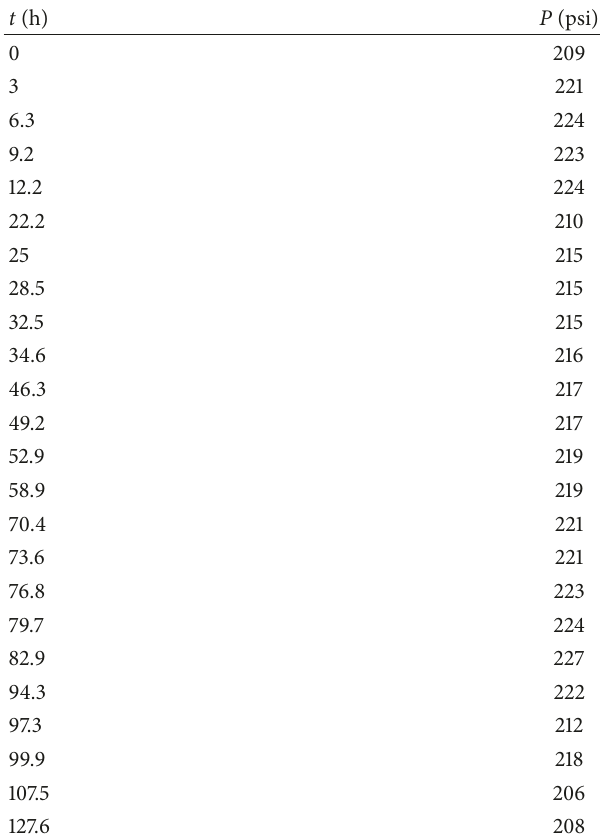
Figure 4: Raman peak areas of CO 2 and the degree of reaction versusreactiontimeat200 ∘ C.Blackrectanglesandredcirclesdenote the peak areas of the lower band at ∼ 1285cm −1 and the upper band at ∼ 1385 cm −1 , respectively. Blue triangles represent the total peak areas of both bands. The green diamonds represent the degree of the reaction. Data plotted are from Table 1.